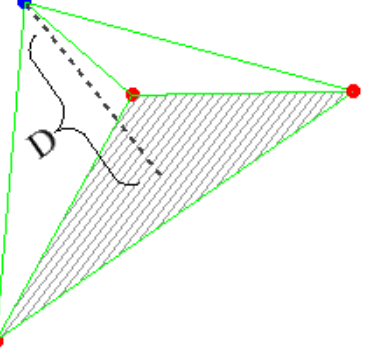
Figure 6. Example of the minimum distance (D) from a point to the plane defined by three neighboring points.